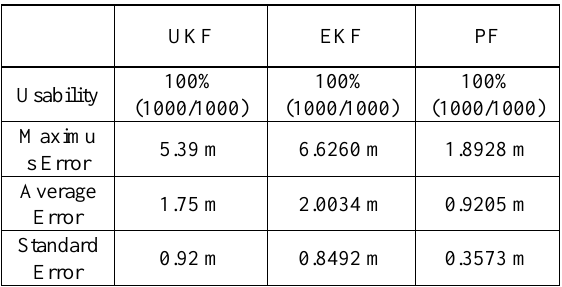
Table 2. Error Analysis Statistical Table of